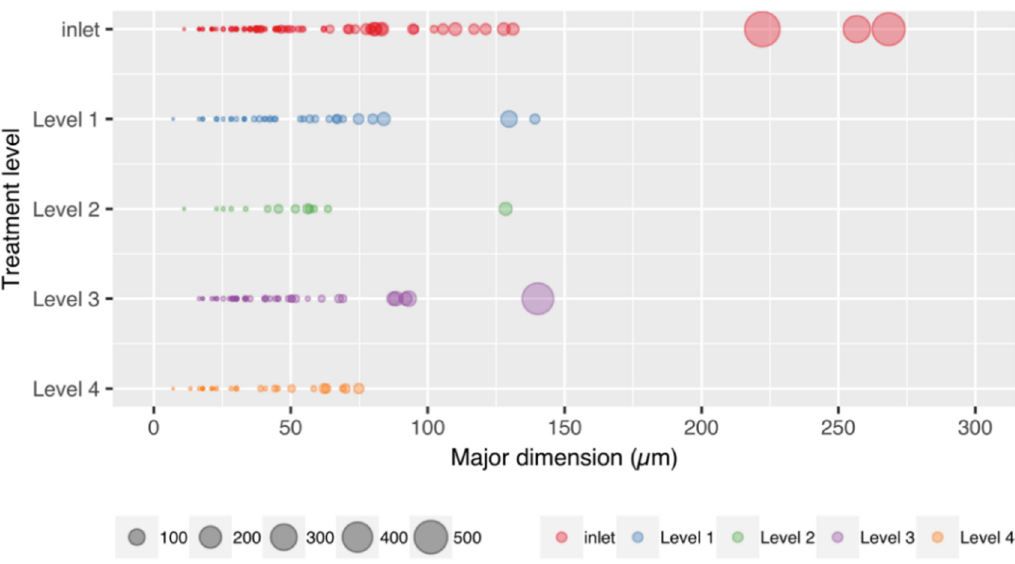
Figure 5. The major dimension of MP particles versus their minor dimension. The size of the data points represents the estimated mass of the particle.